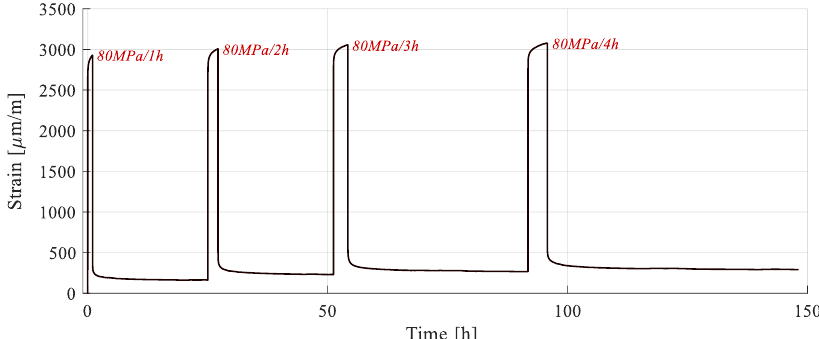
Figure 16. Strain response during a creep-recovery test.